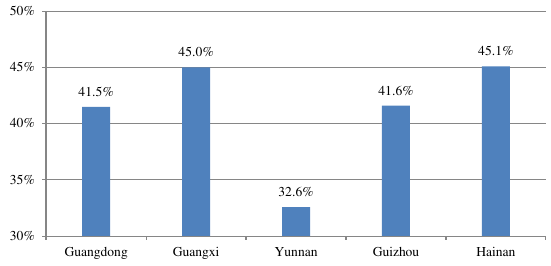
Fig. 2 Load rates of medium-voltage lines of CSG in